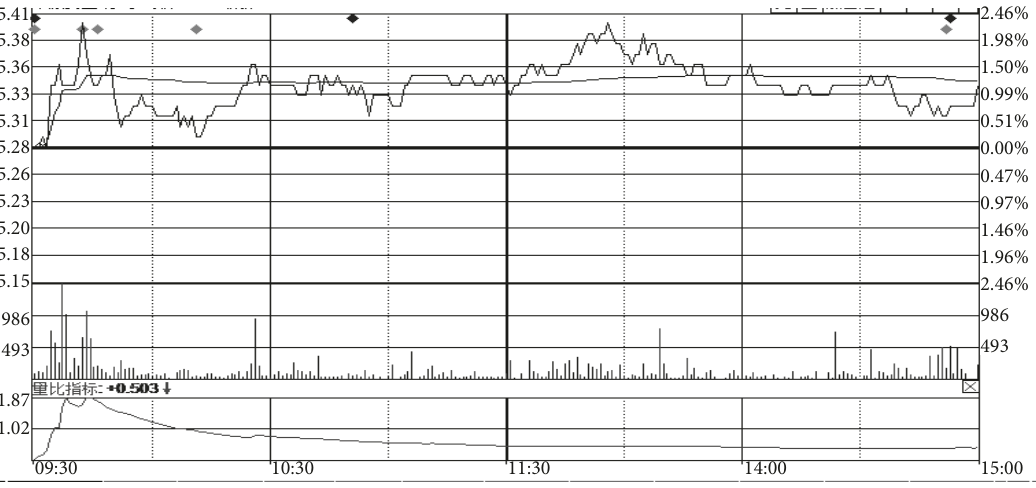
Figure 1: The return rate of stock 601116 on October 24, 2018.